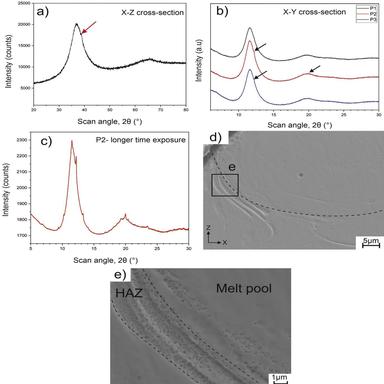
(a) Laboratory XRD pattern (using CuKα radiation) of the printed sample, ground with sandpapers until grit 2500. (b) Synchrotron XRD patterns of three randomly chosen points (P1-P3) of the X-Y cross-section (c) Synchrotron XRD pattern of P2 after longer time exposure (60 s). (d) SEM secondary electron image of the X-Z cross-section, indicating the presence of an HAZ. (e) Higher-magnification image of the area marked by a rectangle in (d), clearly revealing nanocrystals in the HAZ.